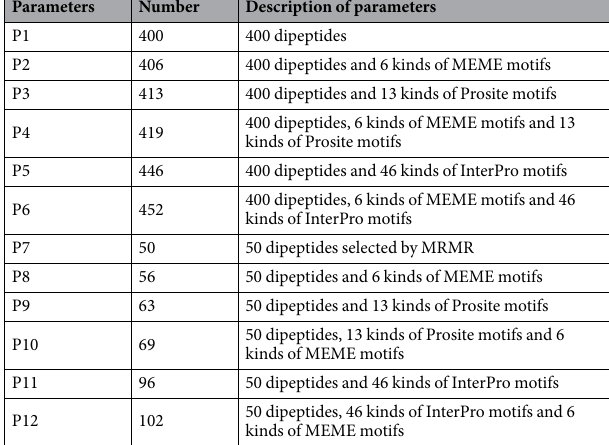
Table 3. Combination of dipeptide parameters and motif